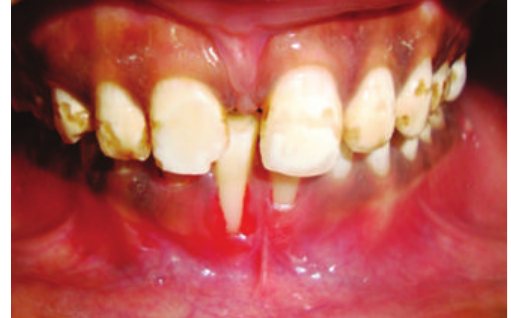
Figure 12: Recession of right central incisor.